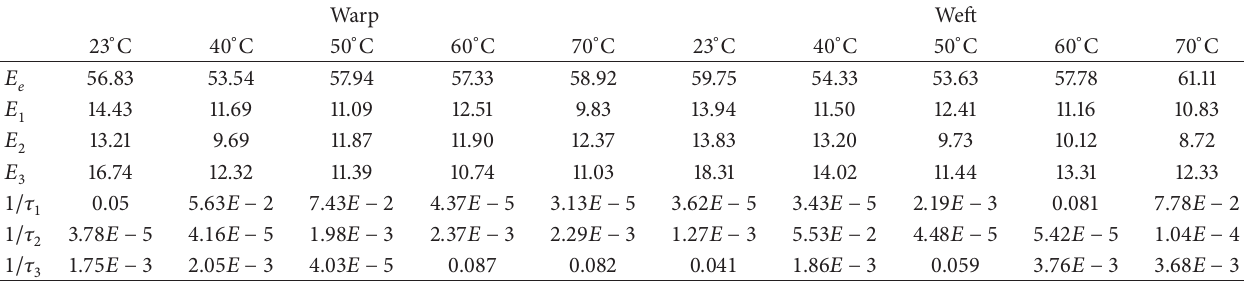
Table 1: Parameter results of the generalized Maxwell model (three-component model).